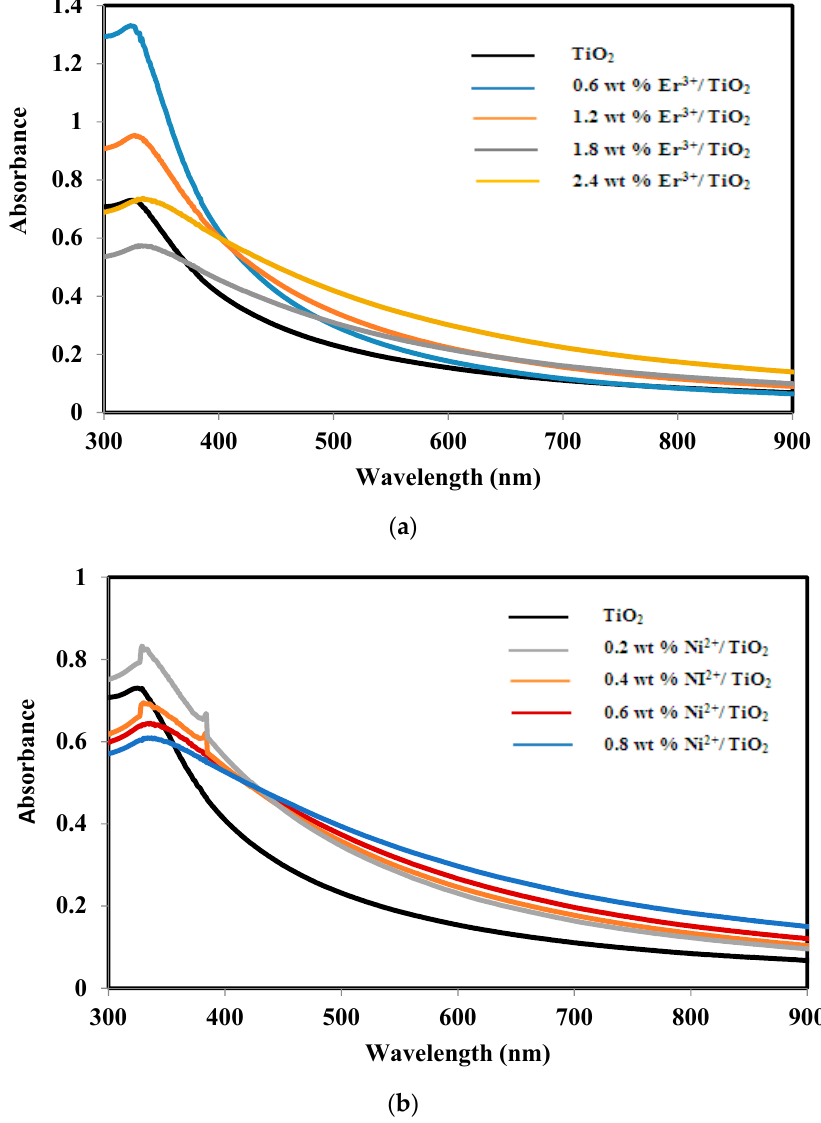
Figure 6. Ultraviolet visible spectra: ( a ) Er 3+ /TiO 2 nano ‐ particles (NPs) and ( b ) Ni 2+ /TiO 2 NPs.